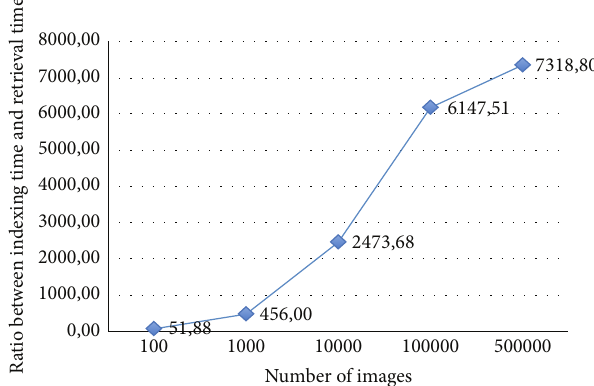
Figure 4: Ratio between indexing time and retrieval time with respect to the collection size for the proposed system.